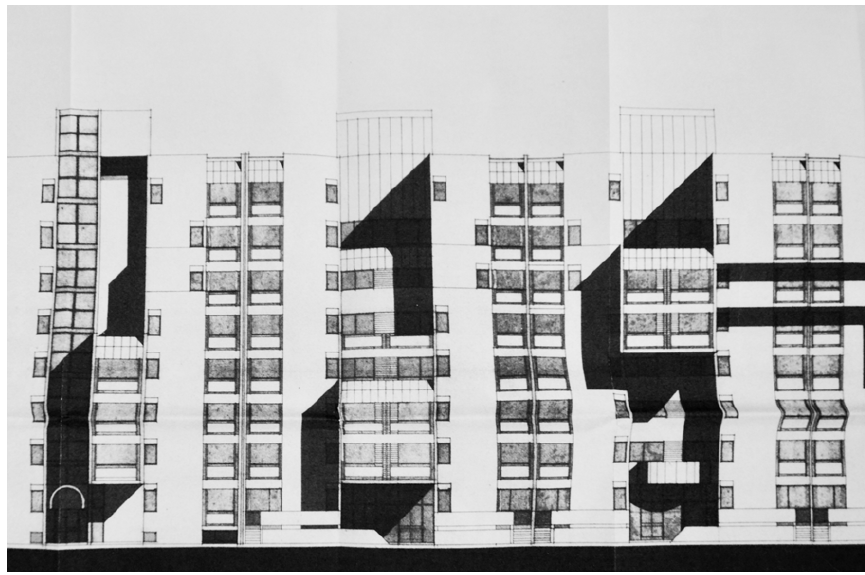
D3, east facade (detail), 1978. (Source: State Archives of Montenegro,